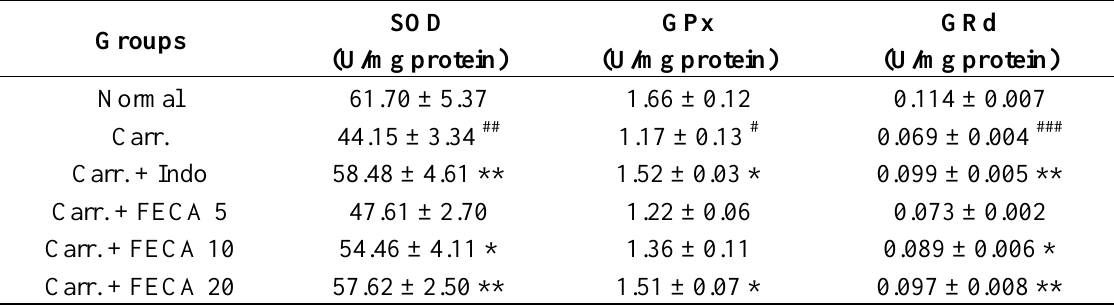
Table 1. Effects of the FECA and Indo on the liver SOD, GPx, and GRd activities in mice. Each value represents as mean ± S.E.M. # p < 0.05; ## p < 0.01; ### p < 0.001 as compared with the normal group.* p < 0.05; ** p < 0.01 as compared with the Carr. (λ-carrageenan) group (one-way ANOVA followed by Scheffe’s multiple range